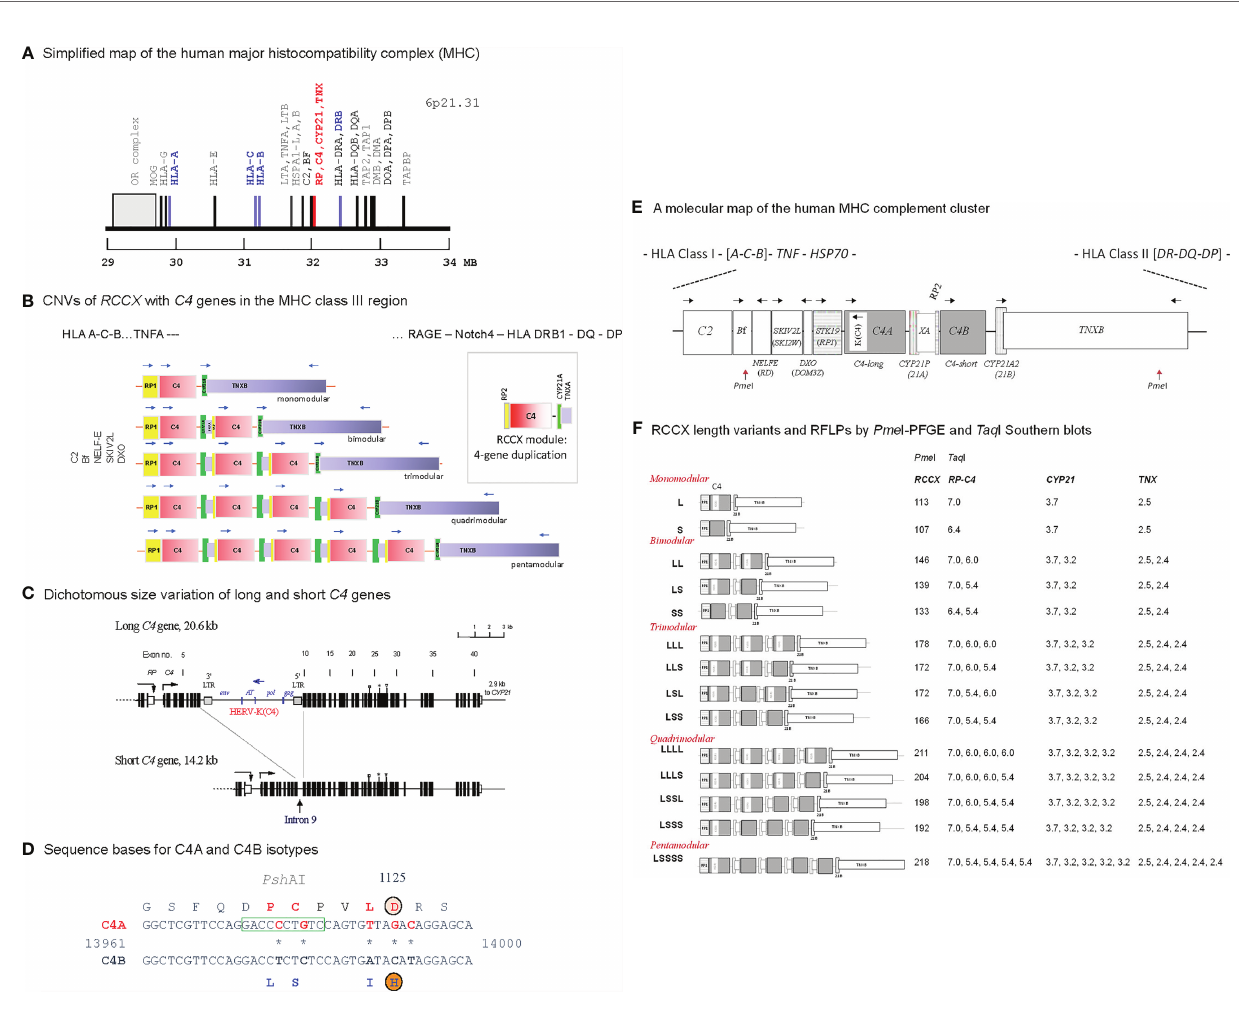
FIGURE 1 | Genetic diversities of complement C4 - concepts and strategies of determination. (A) A simpli fi ed genetic map of the human leukocyte antigen (HLA) on the short arm of chromosome 6 highlighting genes relevant to immune response and in fl ammation. (B) Gene copy number variations (CNVs) of the RP-C4-CYP21- TNX (RCCX) modules (3, 5, 6). Haplotypes with one to fi ve RCCX modules are shown. Blue, horizontal arrows above genes represent gene orientations and directions of transcription. The boxed structure at the right corner represents an RCCX module that is being duplicated. (C) Exon-intron structures with dichotomous size variation of long and short C4 genes. Symbols over exons depict locations encoding for the thioester bond (exon 24), C4A and C4B isotypic residues (exon 26), and major Rodgers and Chido blood group antigens (exon 28) (7 – 9). An inverted arrow under intron 9 of the short C4 gene indicates the corresponding integration site for the endogenous retrovirus HERV-K(C4) in the long genes. (D) Differentiation of C4A and C4B genes and protein isotypes. Amino acid residues speci fi c for C4A are shown in red fonts; amino acid residues speci fi c for C4B are shown in blue fonts. Psh AI restriction enzyme cleavage site speci fi c for C4A is boxed. (E) A molecular map of gene organizations of the MHC-complement gene cluster with a bimodular long-short (LS) RCCX structure. Horizontal arrows stand for transcriptional orientations. The two Pme I cleavage sites that encompass the entire RCCX modules in pulsed fi eld gel electrophoresis (PFGE) are indicated (10). (F) Structures of fourteen known RCCX length variants. The Pme I restriction fragment sizes resolved by PFGE are listed. Detailed experimental protocols for RCCX genotyping and C4 variants can be found in reference (10). The fragment sizes of Taq I restriction fragments for the RP-C4 , CYP21 and TNX are shown on the right panel. Note that some individuals may contain duplicated copies of functional CYP21B ( renamed to CYP21A2) , or rearranged TNXA